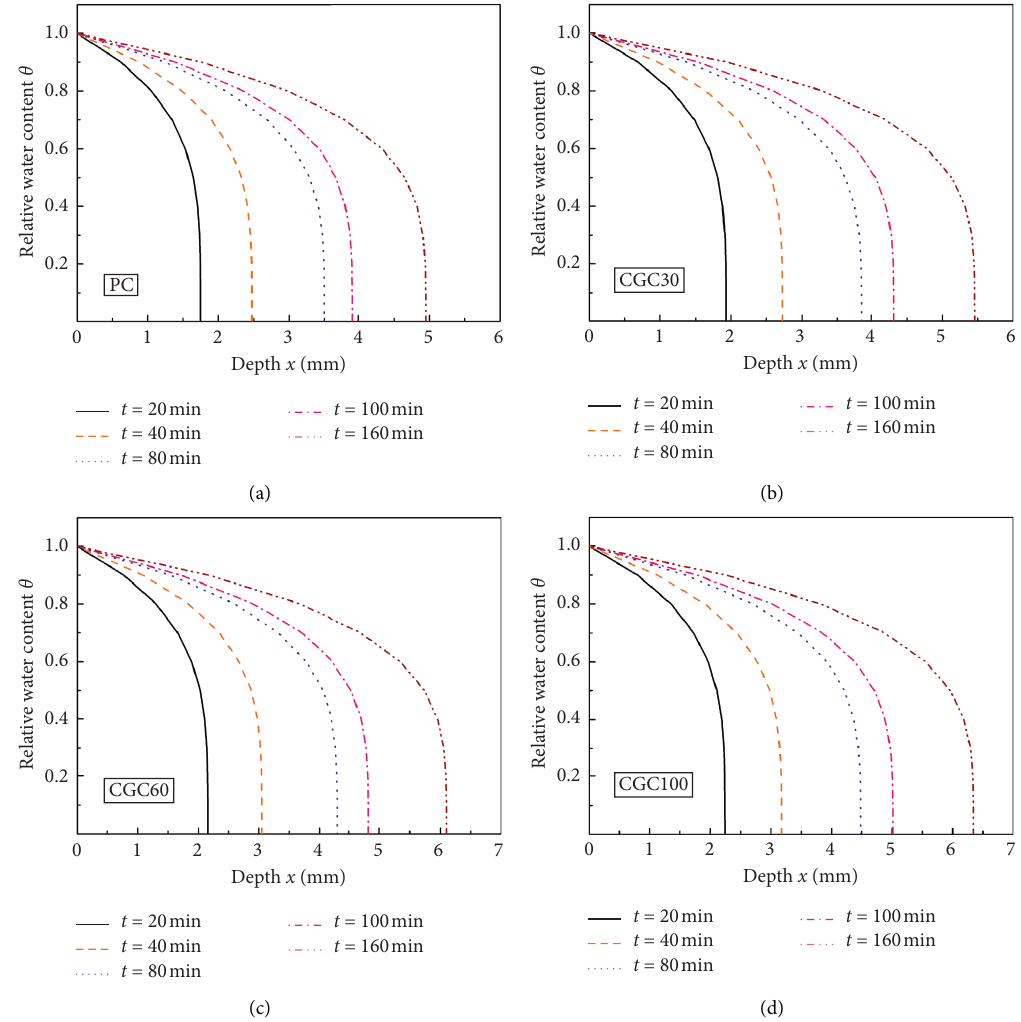
Figure 7: Prediction of water distribution of matrix at different times: (a) PC; (b) CGC30; (c) CGC60; (d) CGC100.